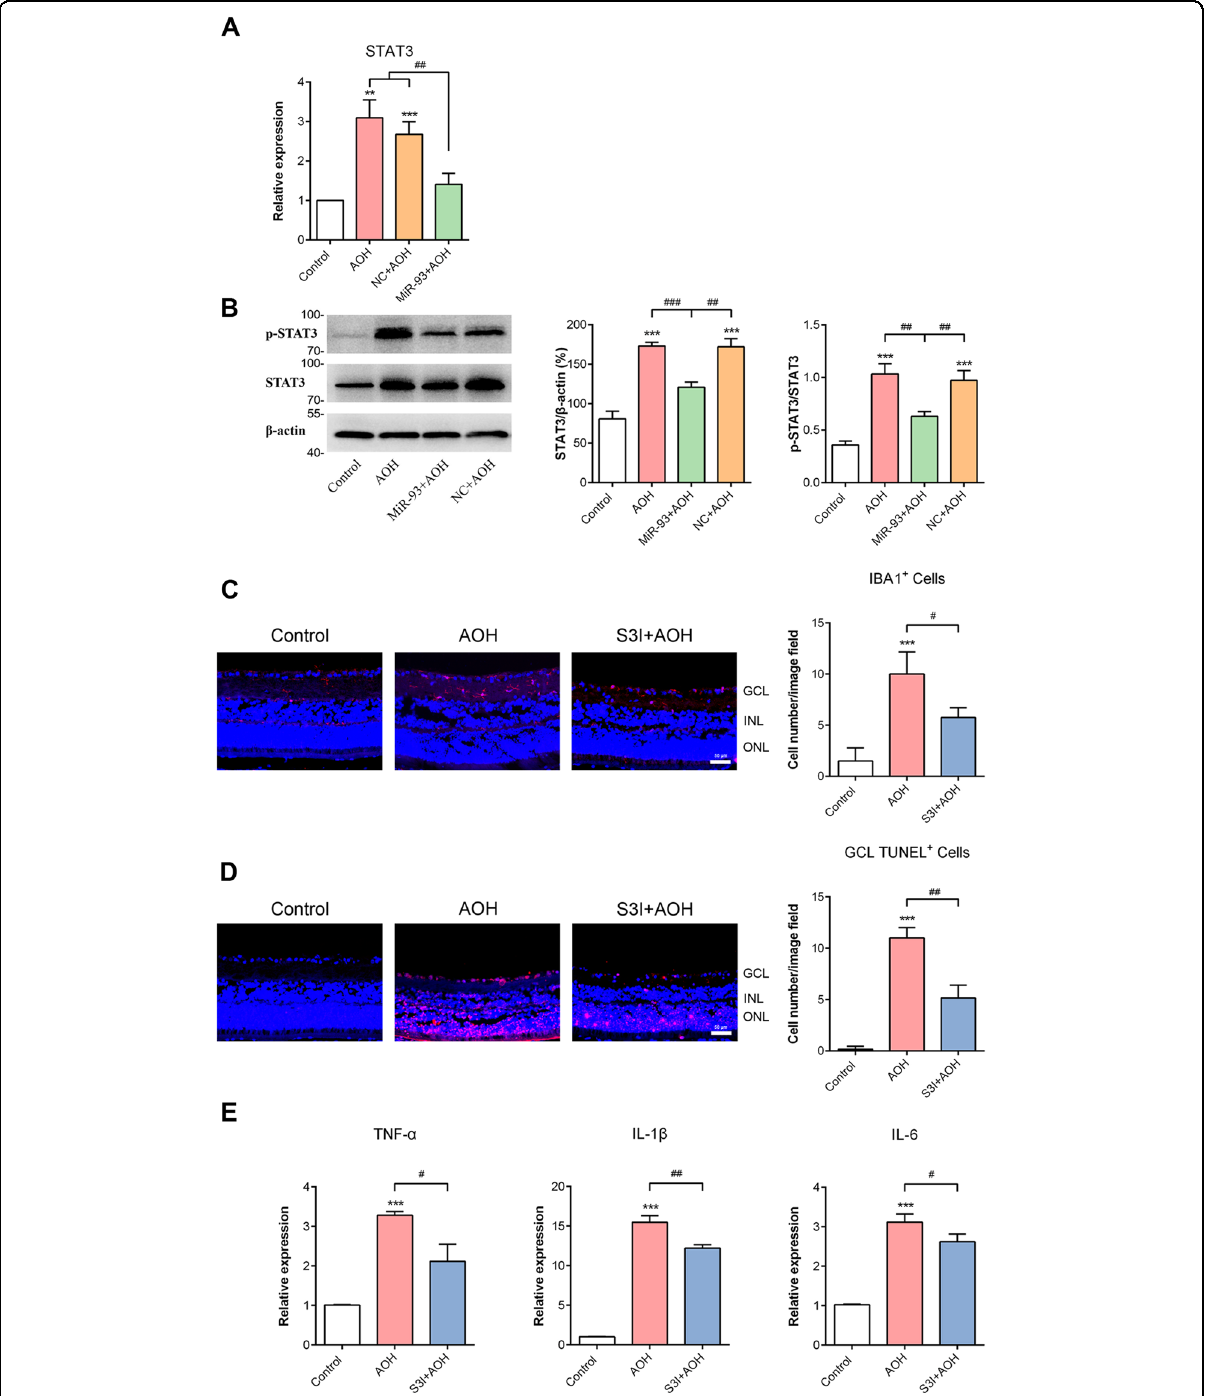
Fig. 3 Overexpression of miR-93 suppressed STAT3 expression and STAT3 inhibitor in fl uenced microglial activation in AOH model. A QRT- PCR showed that the upregulated STAT3 level observed after AOH was signi fi cantly decreased by miR-93 agomir but not by NC treatment. B The relatively high expressions of STAT3 and p-STAT3 protein observed in retinae after AOH was reduced by miR-93 agomir injection, as detected by western blotting. However, intravitreal injection of NC had little in fl uence compared to AOH. C Treatment with a STAT3 inhibitor, S3I – 201 (S3I), could inhibit microglial activation compared to AOH retinae. D S3I treatment reduced retinal GCL apoptotic cells after AOH injury. E S3I treatment inhibited the AOH-mediated overproduction of TNF- α , IL-1 β , and IL-6. Compared with the control: ** P < 0.01, *** P < 0.001. Compared with the AOH or NC group: # P < 0.05, ## P < 0.01, ### P < 0.001. n = 3 retinae. NC negative control, miR-93 miR-93 agomir, S3I + AOH, S3I – 201 +